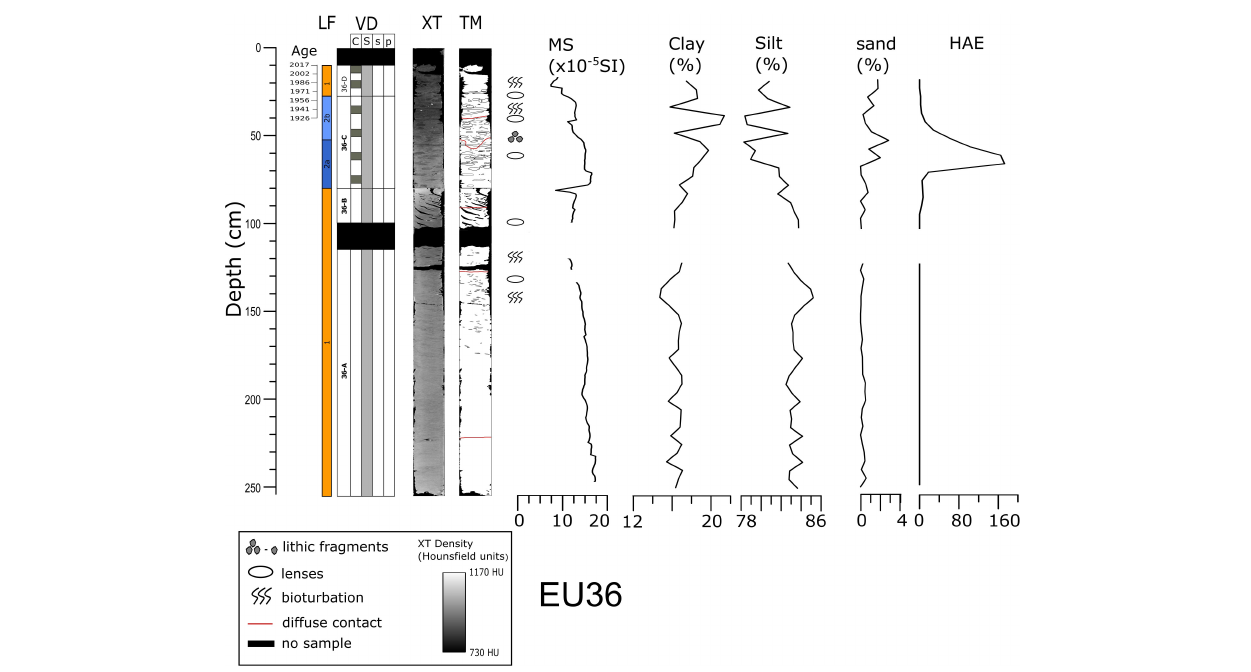
FIGURE 9 | EU36 sediment core with lithofacies identification (LF); Age (from 210 Pb dating); original granulometric visual description (VD), showing Clay (C), Silt (S), sand (s) and pebbles (p) contents; X-Ray tomographic image (XT), and interpreted mapping (TM); magnetic susceptibility (MS); laser granulometry showing clay, silt and sand contents; high attenuation elements from XT